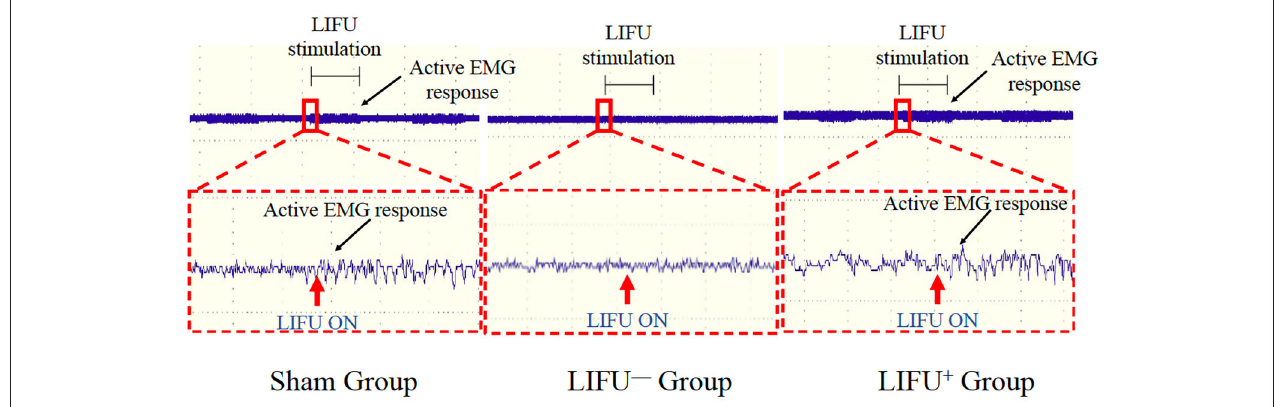
FIGURE 2 | Activation of the spinal cord neurocircuits by low-intensity focused ultrasound (LIFU) stimulation. The red arrow shows the LIFU turning on point; the black arrow shows the active EMG response.